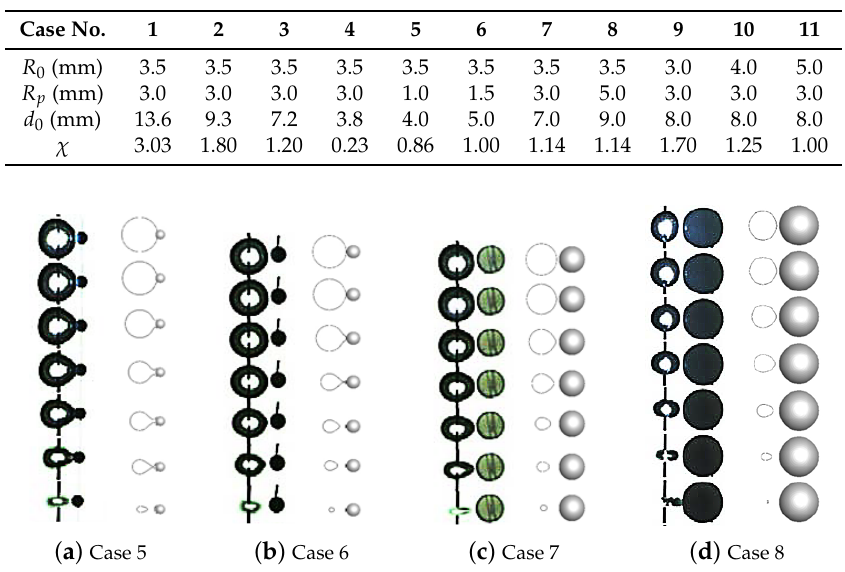
Table 2. Information of parameters in the initial flow field shown in Figure 1 under each case.